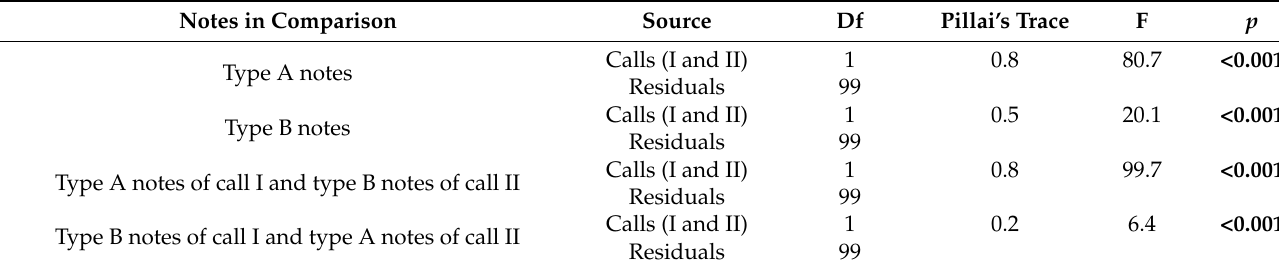
Table 3. Results of MANOVA tests comparing each note (introductory and/or secondary) of the two types of advertisement calls (calls I and II) distinguished by random forest analysis. Bolded p -values correspond to significant results with α = 0.05.